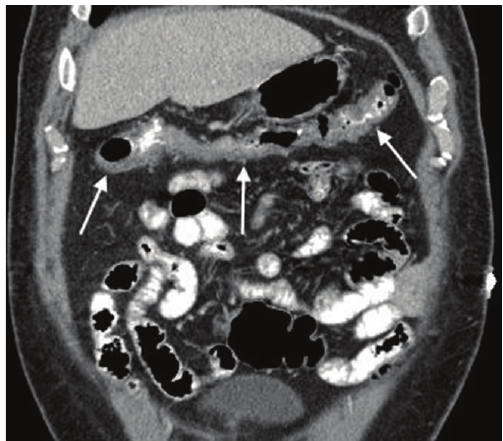
Figure 2: Long segment of circumferential wall thickening of transverse colon.